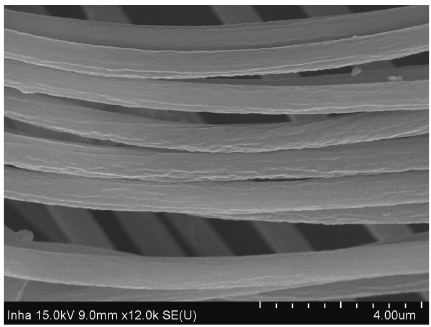
Figure 3: The SEM image of polyethylenimine (PEI) nanofibers.